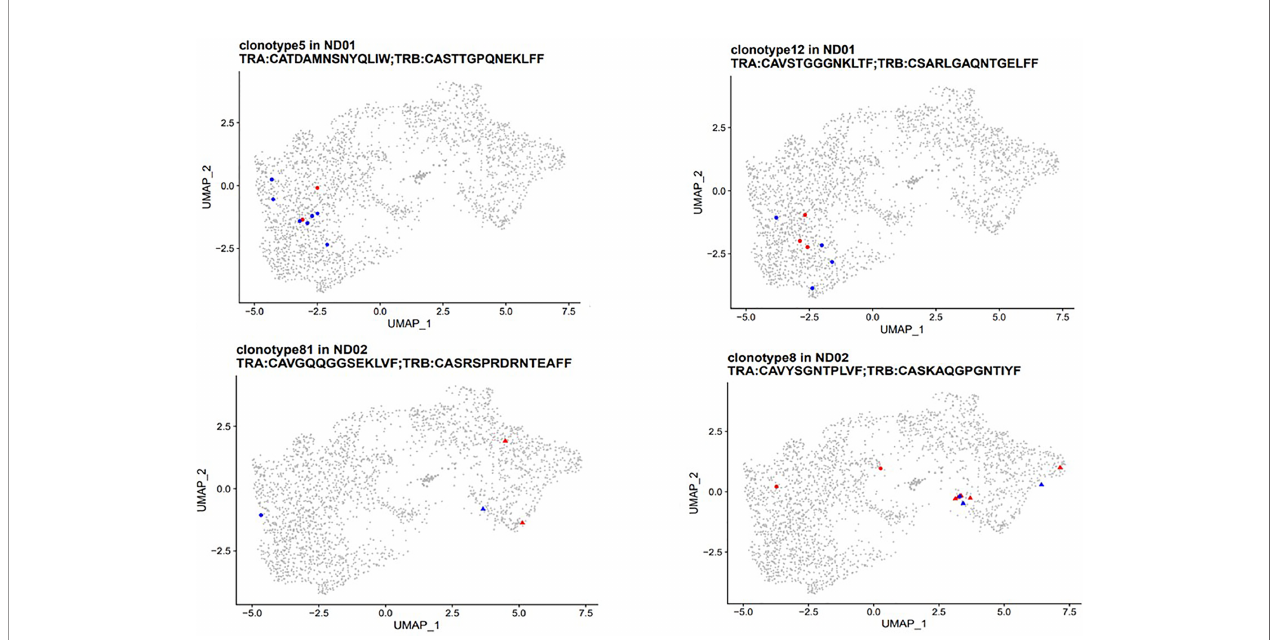
FIGURE 6 | PBMCs from subjects with type 1 diabetes were stimulated with native [proinsulin peptides: C13 – 32, C19-A3, C22-A5; GAD peptides: 115 – 25, 265 – 284) and neoepitopes (C-pep-IAPP1, C-pep-NPY, GAD 115 – 127 (120E), GAD 265 – 284 (272 cit)]. Antigen-responsive cells were identi fi ed by and sorted on expression of CD154/CD69. Immune pro fi ling was conducted on single cells from which cDNA was synthesized, followed by library construction and sequencing as described in Methods . TCR clonotypes (both a and b chains) were examined in patients ND01 (top panel) and ND02 (bottom panel). T cells responding to native epitopes are shown in red and those responding to neoepitopes are shown in blue. Clusters are marked by point shapes (circle, triangle, and